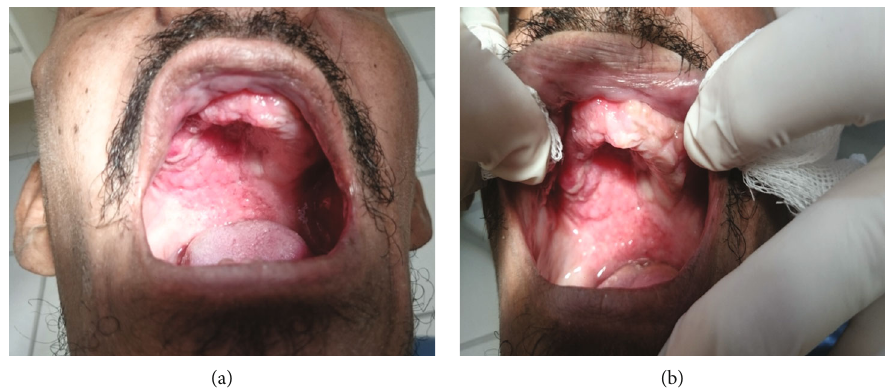
Figure 1: Clinical aspect of intraoral lesions in the palate and alveolar ridge regions (a, b).